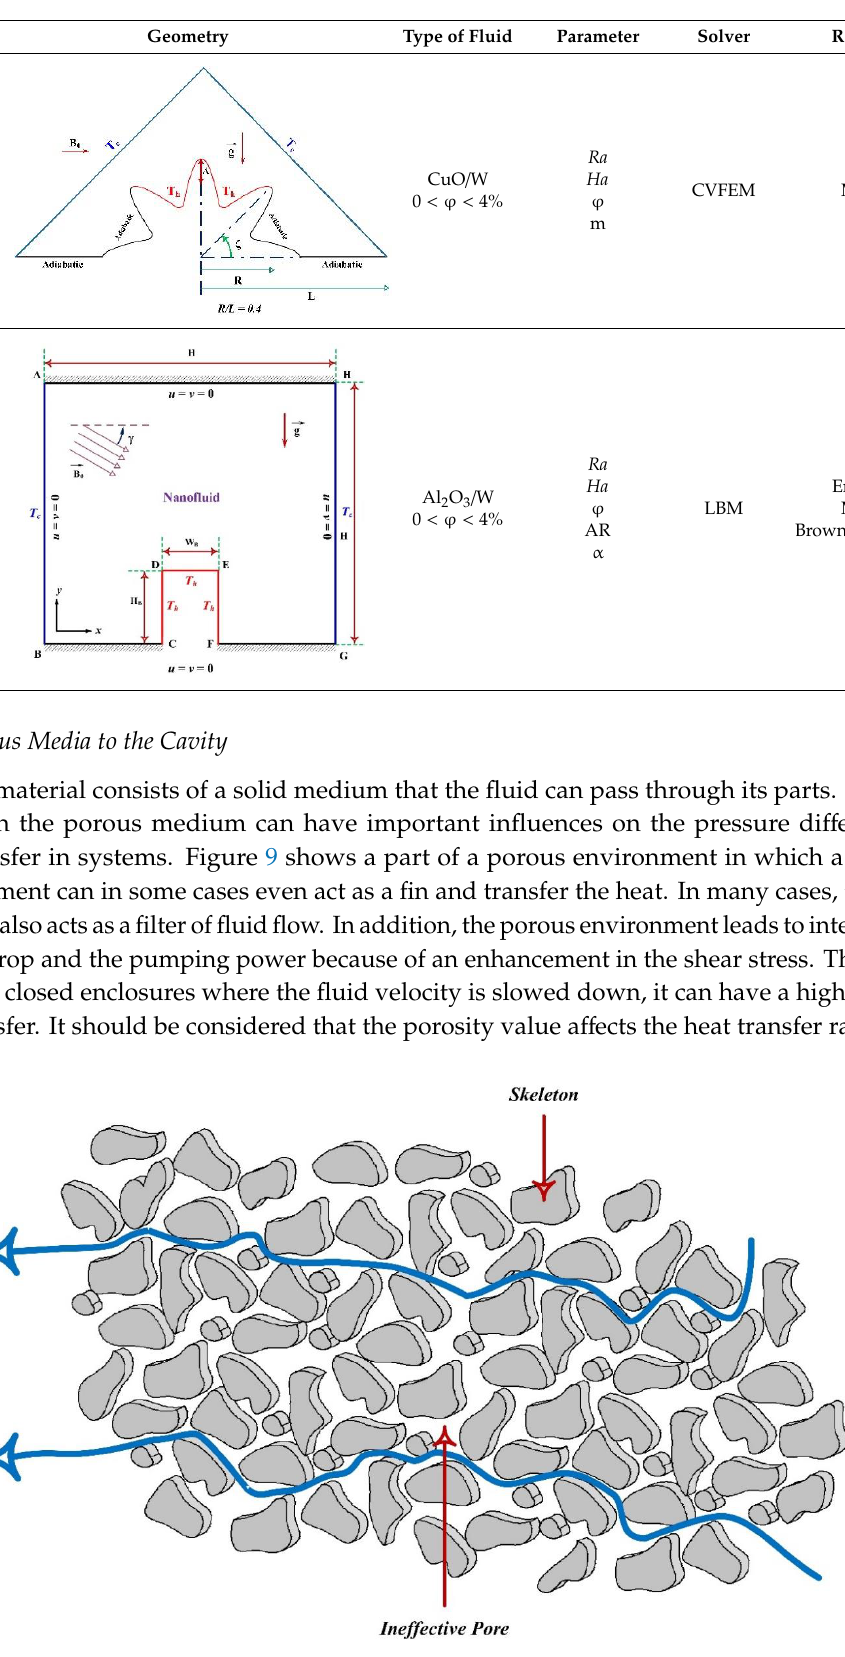
Figure 9. Schematic of a porous medium in which a fluid flows [216].